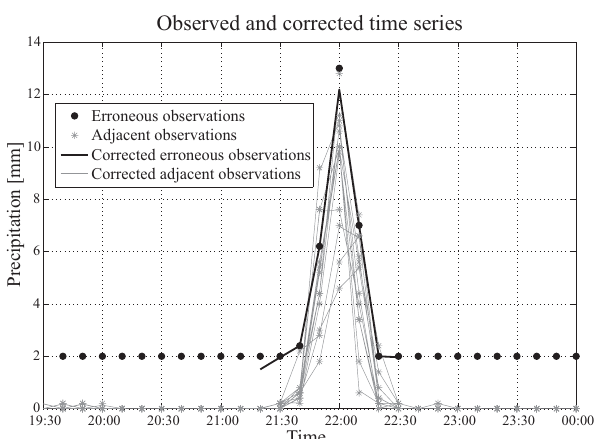
Fig. 13. Time series of observed (dots and asterisks) and corrected (solid lines) 10min precipitation values on 20 June 2007. VERA- QC was carried out including all three dimensions ( x , y , t ). In this period, one station (symbolized by the black markers) constantly registered precipitation values of 2mm even though no precipitation was observed in its surroundings (symbolized by the gray markers). Note that if the black line (presenting corrected values) is missing, the corresponding observation was identified to be a gross error and hence is